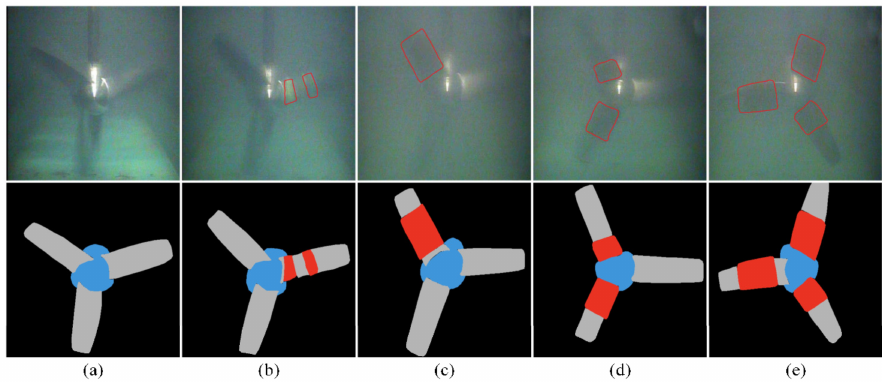
Figure 1. The images of MCT blades and the corresponding GT under different conditions of attachment simulation. The red box in the images indicates the area covered by the attachment. The forms of attachment are: ( a ) healthy; ( b ) single blade sparsely attached; ( c ) single blade densely attached; ( d ) double blades densely attached; ( e ) triple blades densely